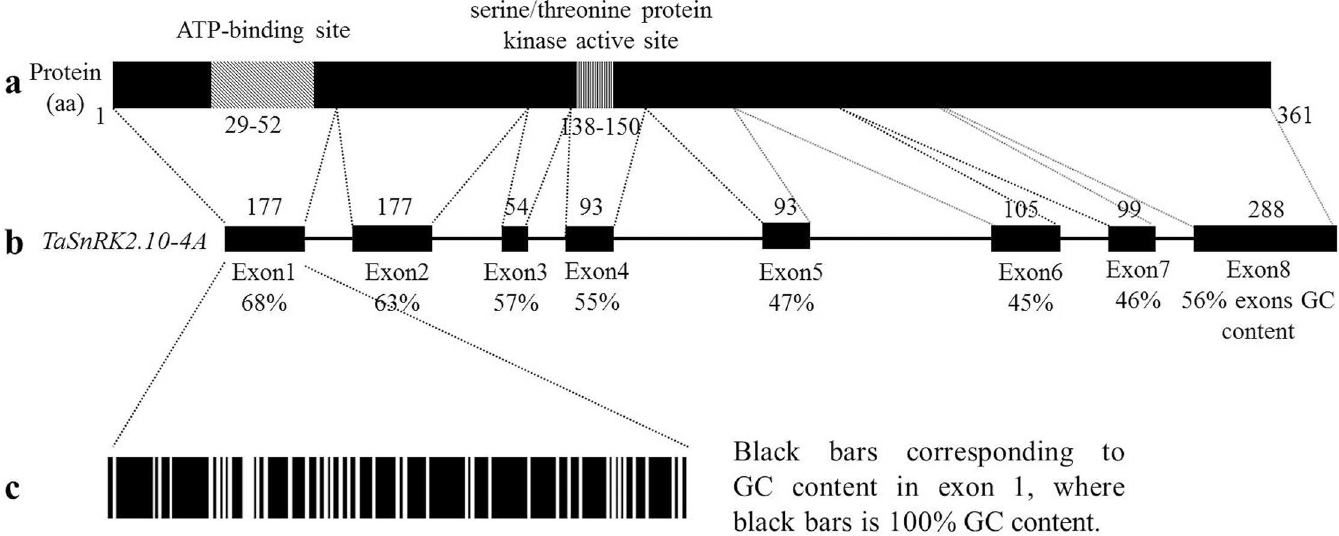
Fig 1. Schematic diagram of the TaSnRK2 . 10 gene. (a) Known functionaldomainsof TaSnRK2 . 10 protein are highlighted;ATP-binding site in diagonal stripes, serine/threonineprotein kinase active site in vertical stripes. Amino acid positionsof functionaldomainsare indicatedbelowthe protein structure. (b) Exon-intron structure of TaSnRK2 . 10-4A genewith its eight coding exons in black boxes; the number of base pair sequenceof ORF is listed aboveeach exon; The percentage of GC content for exon 1–8 is indicatedbelow each exon. (c) The GC content in exon 1.